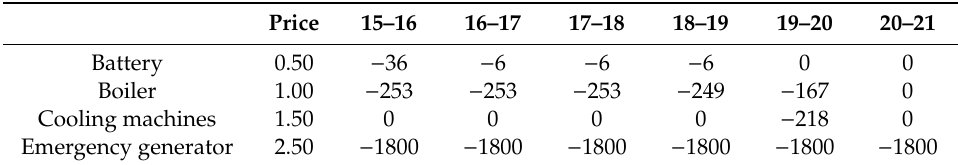
Table 14. Bids for iteration